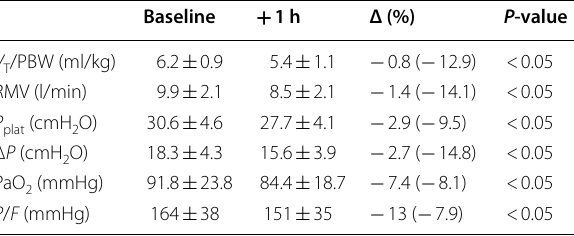
Table 4 Changes in ventilation and oxygenation parameters between baseline and after reduction in tidal